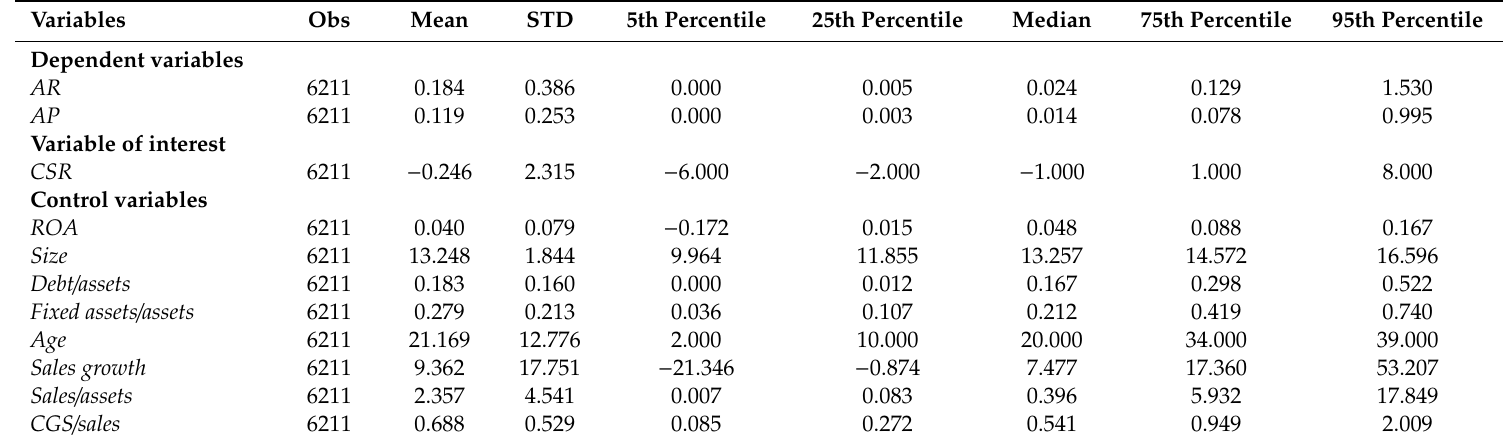
Table 2. Summary